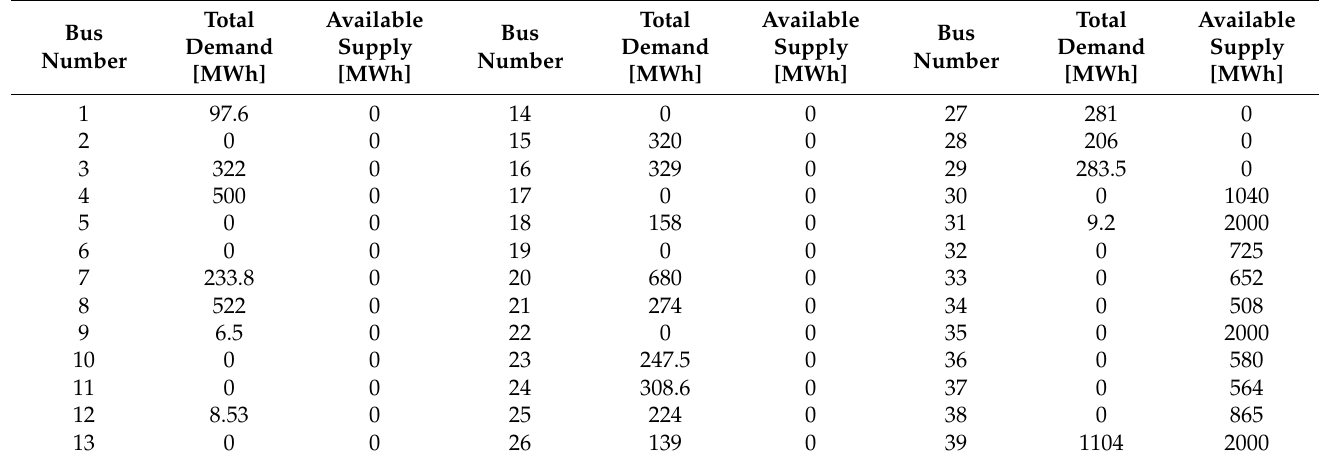
Table 1. Total demand and available supply at each bus in IEEE 39 mesh network case.